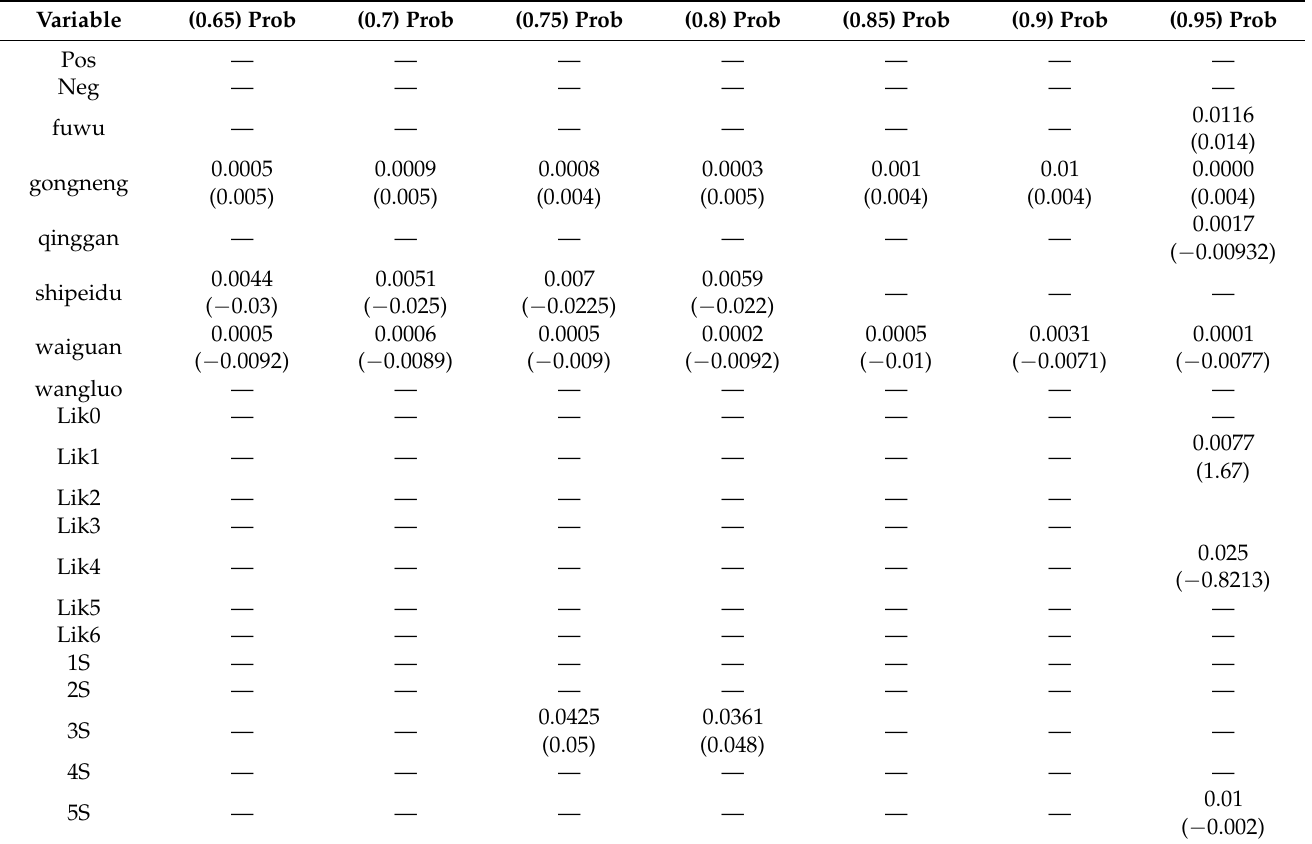
Table 16. Variables significant at 0.65 to 0.95 points.